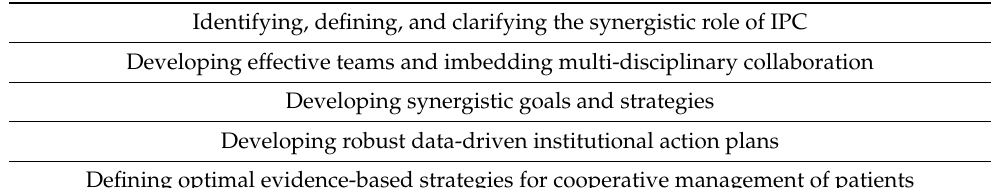
Table 1. Enablers to leverage synergy between infection prevention control and antibiotic